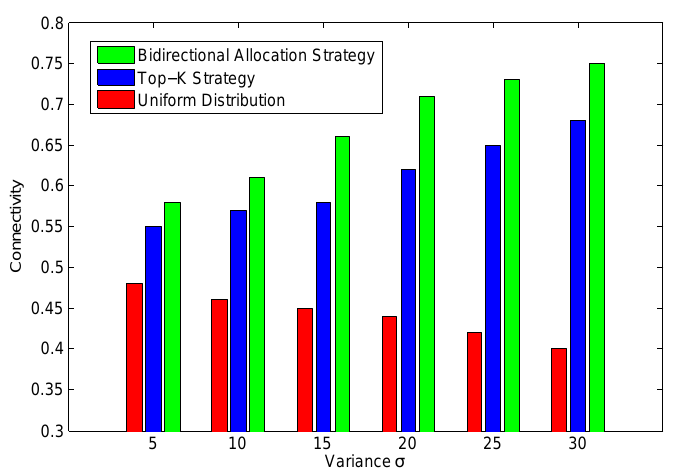
Figure 10. Connectivity with vehicle density variation.